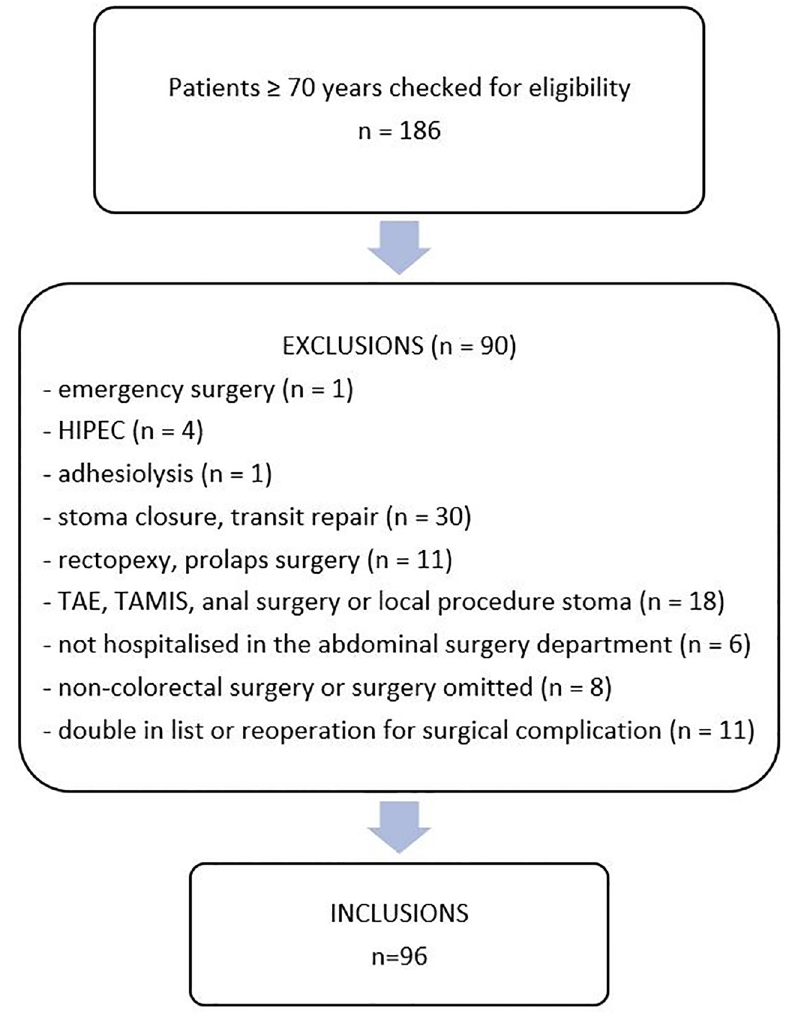
Fig 1. Flowchart of the study recruitment. HIPEC: hyperthermic intraperitoneal chemotherapy; TAE: transanal excision; TAMIS: transanal minimally invasive surgery.